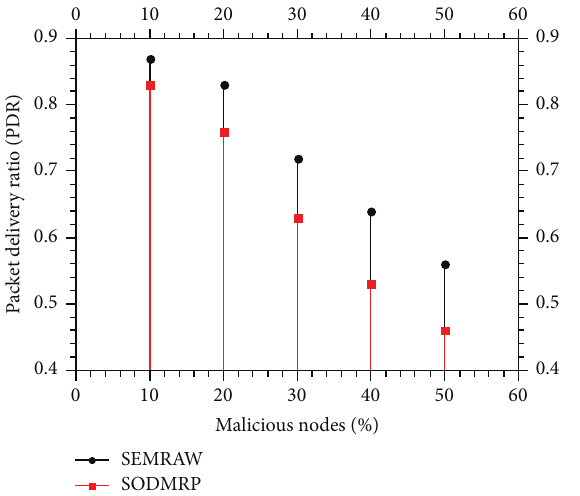
Figure 2: Performance comparison in terms of PDR.